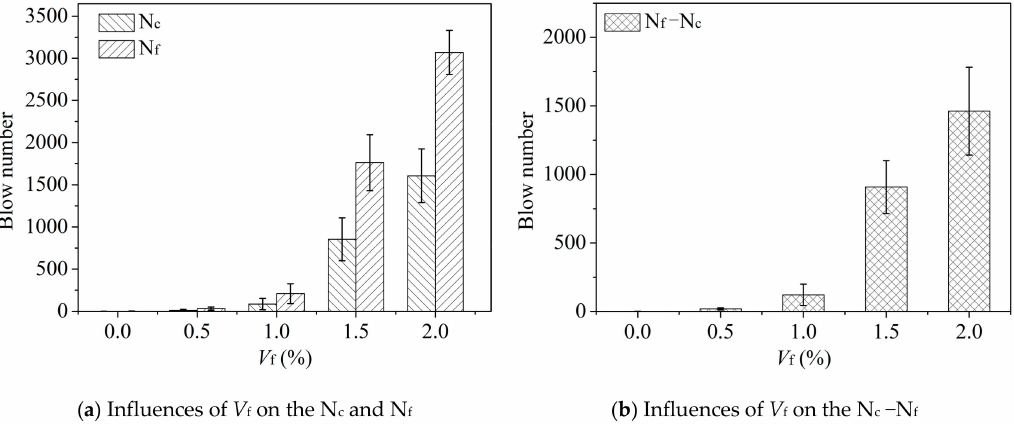
Figure 6. Influences of V f on blow